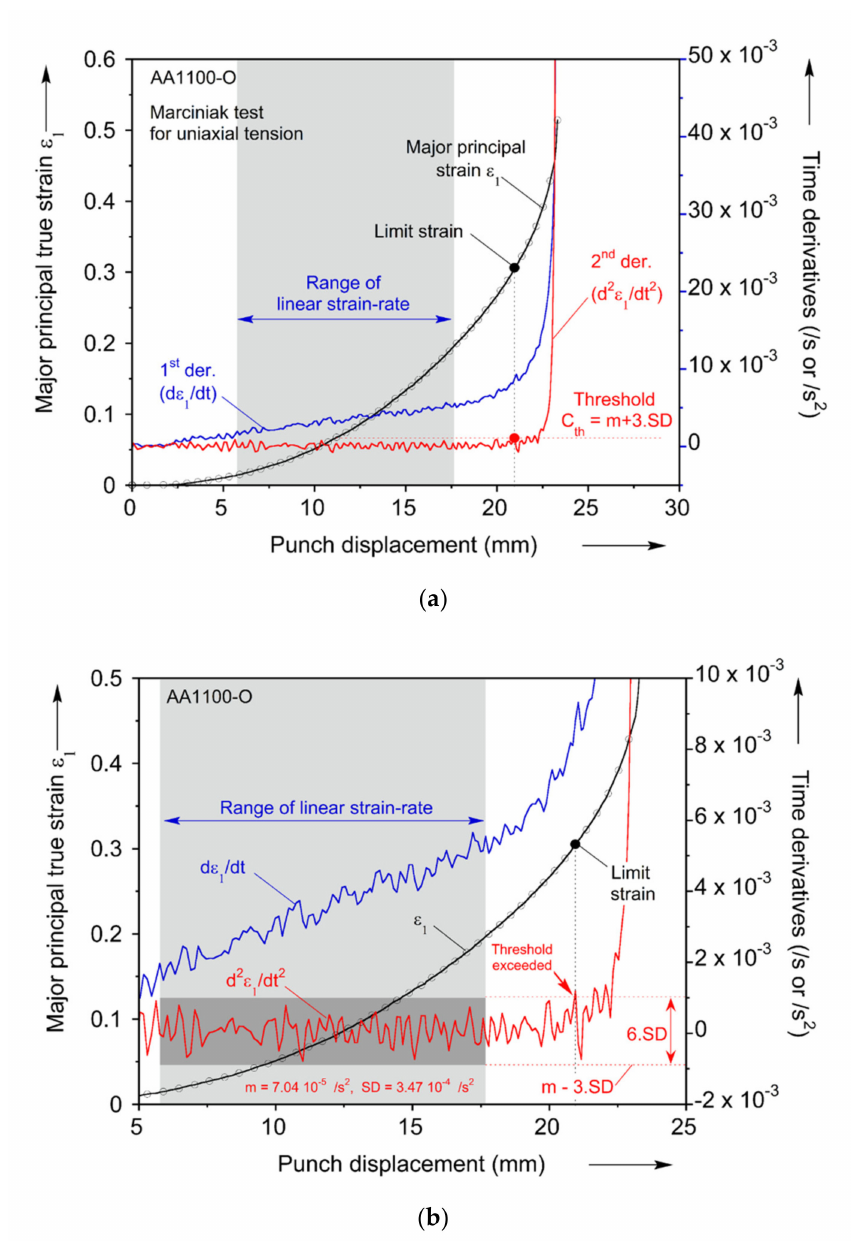
Figure 19. Determination of FLC points by ( a ) the second time-derivative method and ( b ) its close-up near the limit